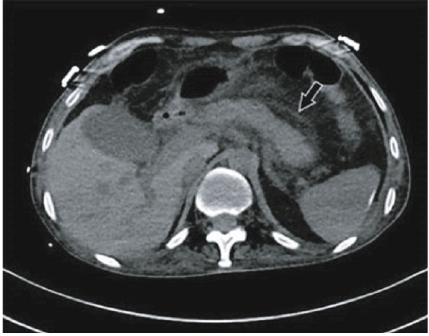
Figure Abdominal noncontrast-enhanced computed tomography in a 44-year-old man recovering from severe coronavirus disease 2019 pneumonia with signs of acute pancreatitis, including in fl ammatory changes in peripancreatic fat in the pancreas (white-framed arrow).